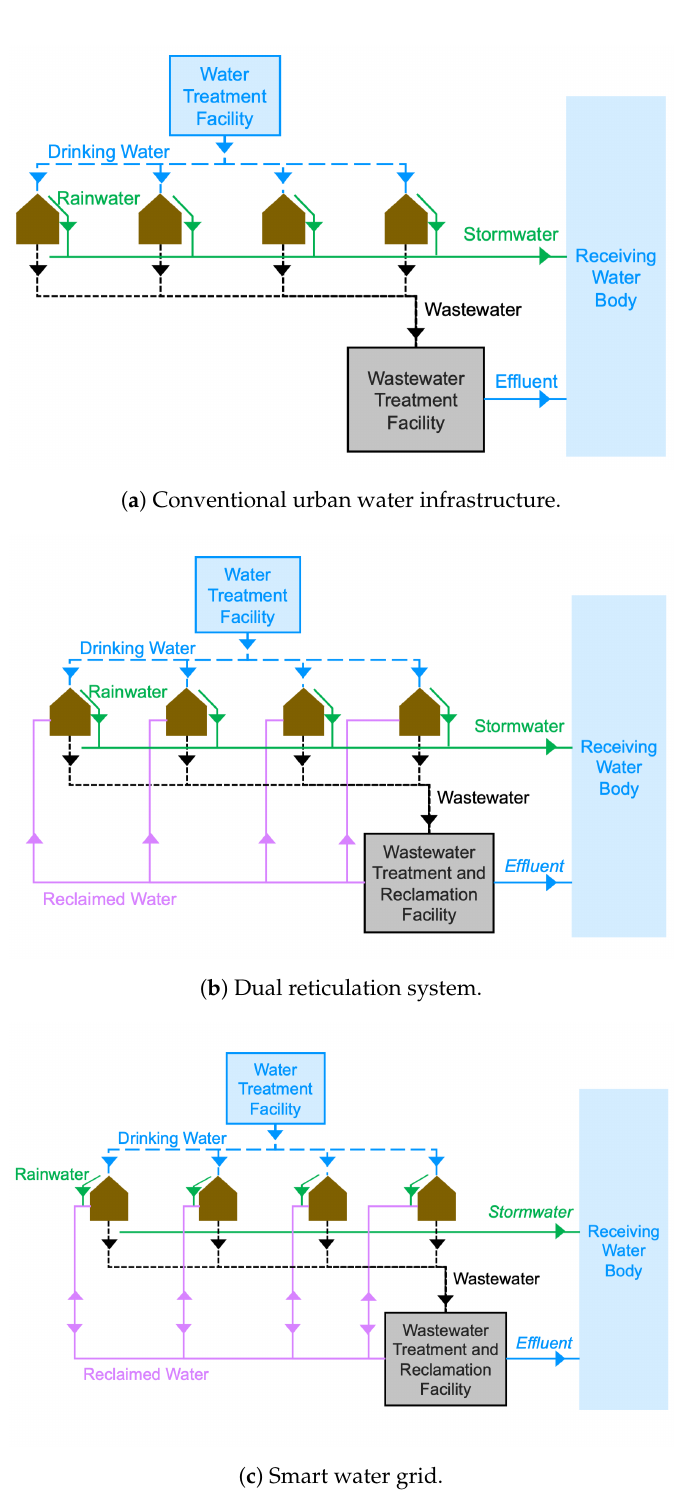
Figure 1. ( a ) Conventional urban drinking water, wastewater, and stormwater systems. ( b ) A dual reticulation system closes the loop in the urban water cycle by treating wastewater and providing it for non-potable household uses. Effluent flows from the wastewater facility are reduced. ( c ) A smart water grid increases water efficiency in the urban water cycle by allowing households to contribute rainwater to the dual reticulation system. Effluent and stormwater flows are